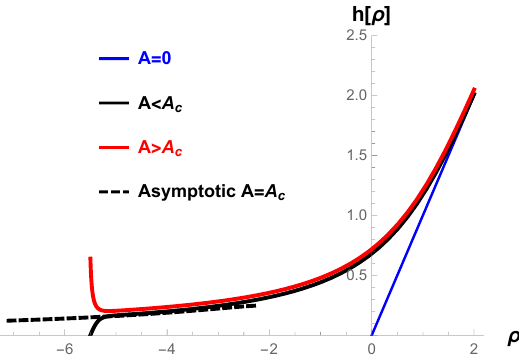
Figure 2 . Shown are numerical solutions of h ( ρ ) , in the k → ∞ limit, for different values of A (solid) and the analytical asymptotic solution from (3.4) (dashed). The black curve is the plot of a solution for A slightly below A c . The red curve is a solution for A slightly above A c ; it is shifted up a bit to make it visible. Below A c , the geometry has a tip. Above A c , it has a hole followed by a divergence. The critical solution, for A = A c , when both curves coincide and which connects smoothly to the asymptotic solution, is the punctured Euclidean black hole. In the plot, both curves have an amplitude A that deviates from e − γ/ 2 in (2.13) only in the 11 th digit after the decimal